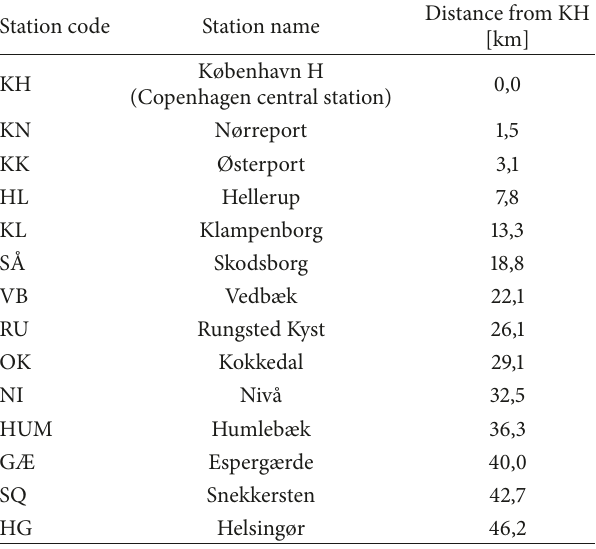
Table 3: Station codes and names on the Kystbanen. Station